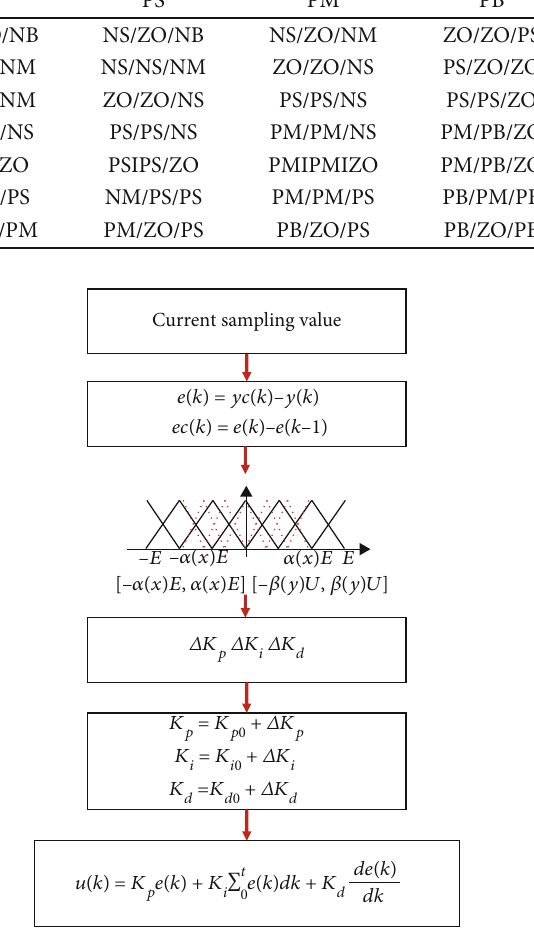
Figure 6: Control logic structure diagram of variable universe fuzzy PID. yc ð k Þ is set as the point